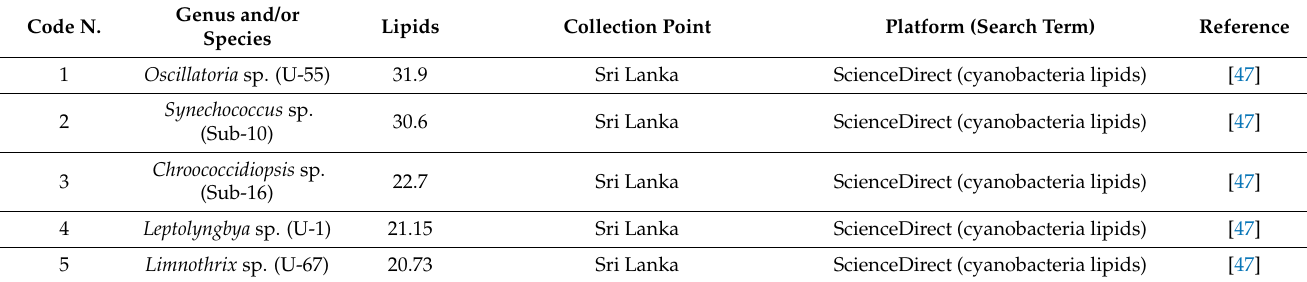
Table 5. Lipid content in cyanobacteria selected for this review [17,28,32,35,36,40,41,45,47–67] 1 . Code